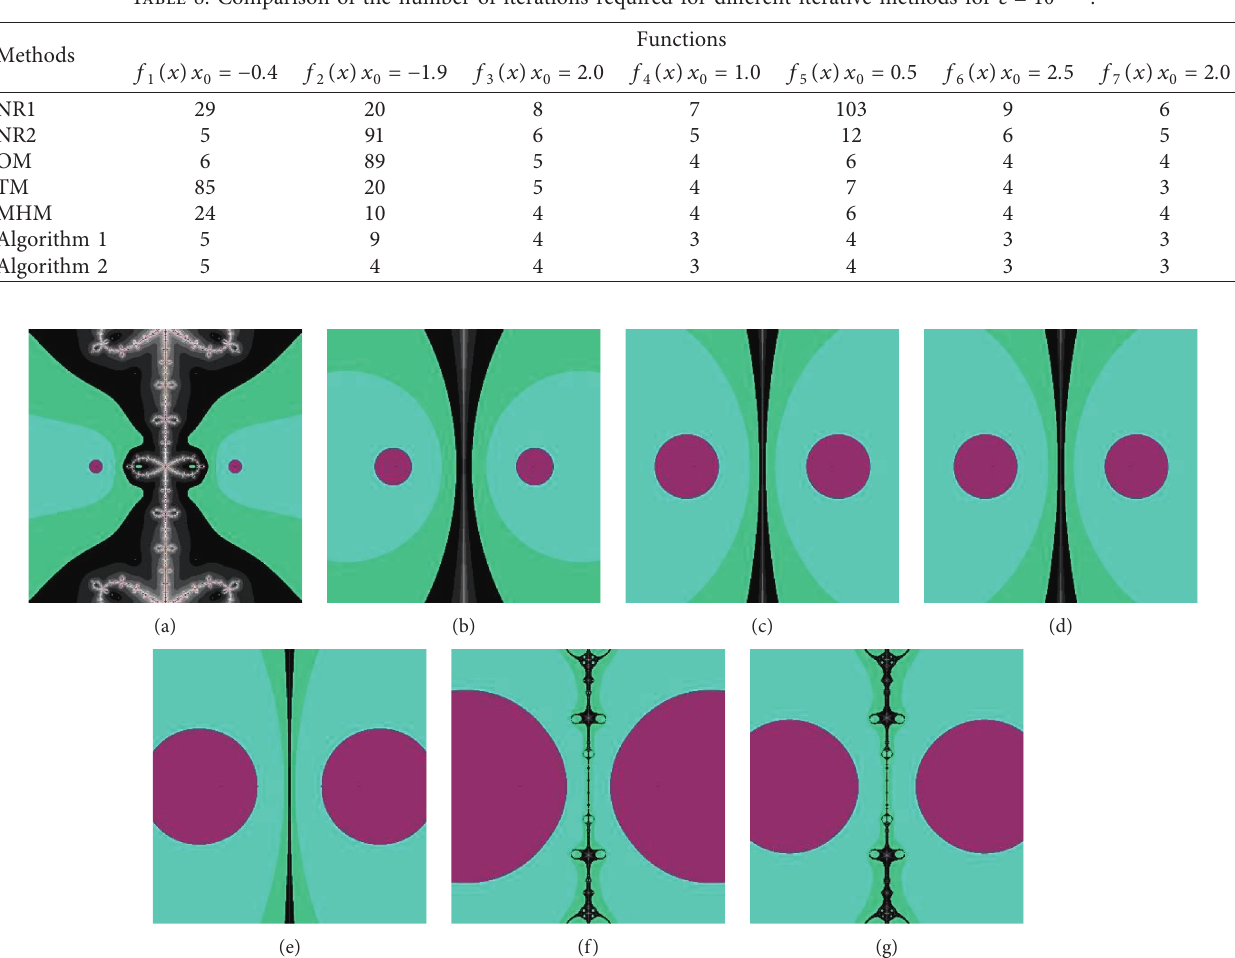
Figure 1: Polynomiographs for the polynomial p NR1. (b) Polynomiograph for the polynomial p